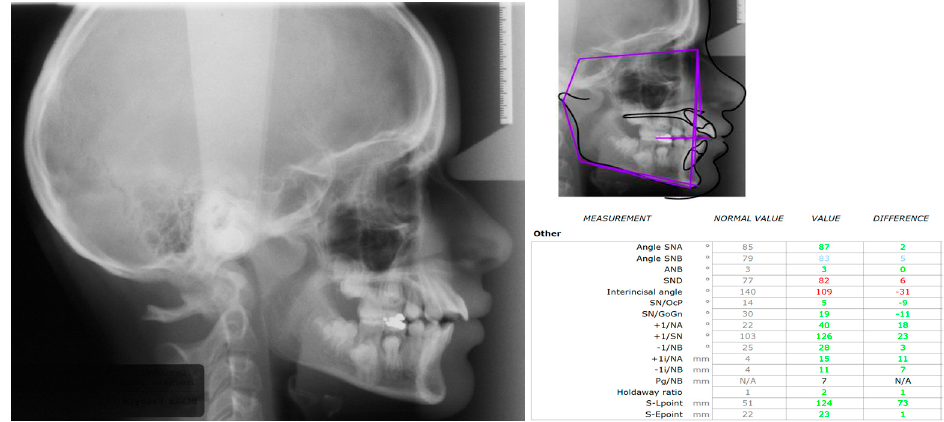
Figure 2. Pretreatment cephalometric radiograph showing a skeletal Class II profile.